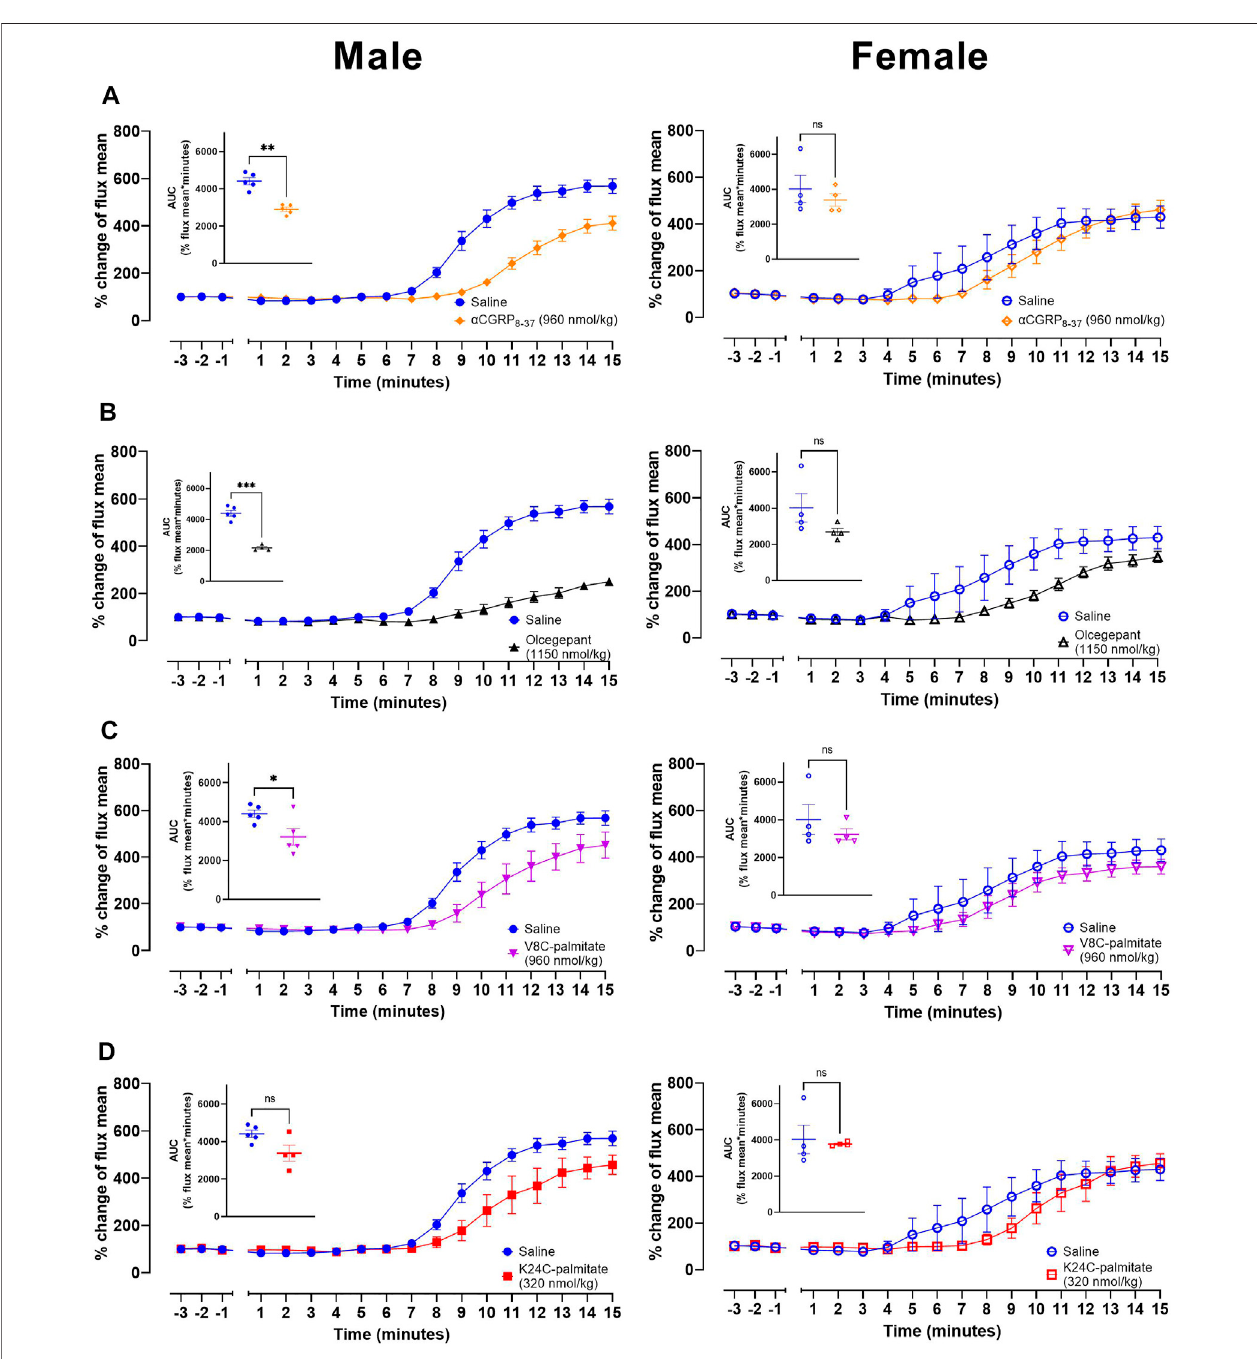
FIGURE 7 | CGRP receptor antagonists attenuate CGRP action in vivo . Effects of (A) α CGRP 8-37 , (B) olcegepant, (C) V8C-palmitate and (D) K24C-palmitate on CIDVinmale(left)andfemale(right)mice.InsetgraphsshowcorrespondingAUCmeanvaluesoverthe15 minmeasurementtimeframefollowingcapsaicinapplicationto the ear. ns p > 0.05, * p < 0.05, ** p < 0.01, *** p < 0.001. Each treatment group comprises four to fi ve mice with corresponding saline controls.